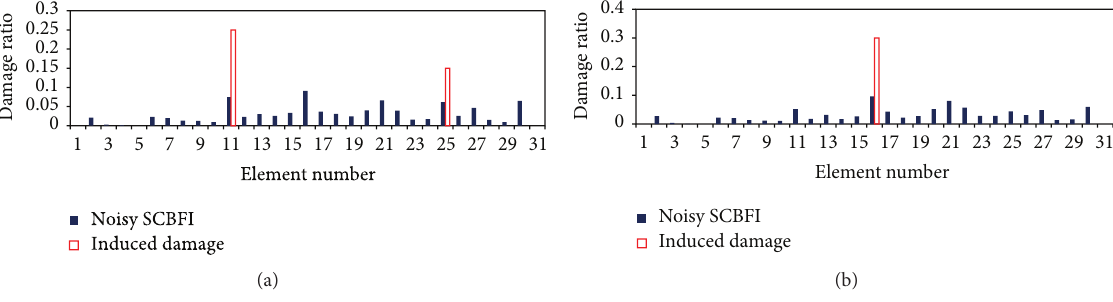
Figure 15: The SCBFI for 31-bar truss considering 3% noise for (a) case 1 and (b) case